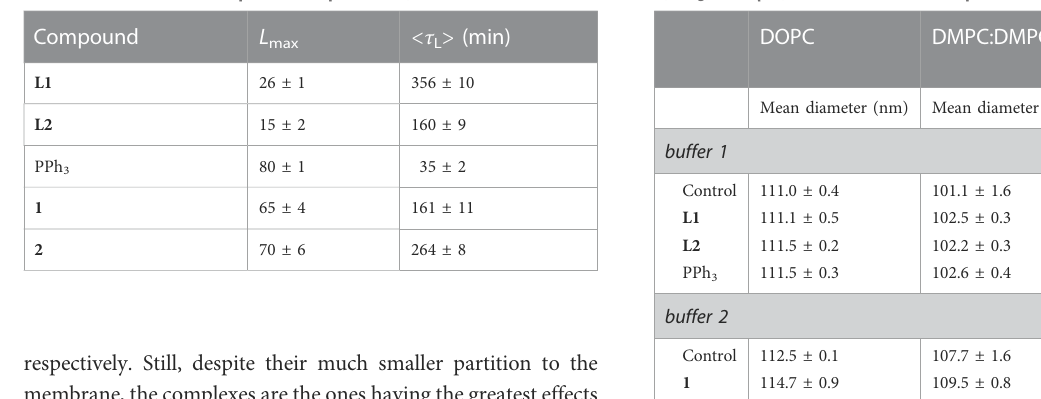
TABLE3MeandiameterofLUVscomposedbyDOPCandDMPC:DMPG(7:3) and zeta potential ( ζ ) of DMPC:DMPG LUVs (7: 3) in the absence (controls) and presence of the compounds (1 h incubation, c = 20 μ M, except c(PPh 3 ) = 10 µM). Controls refer to samples without